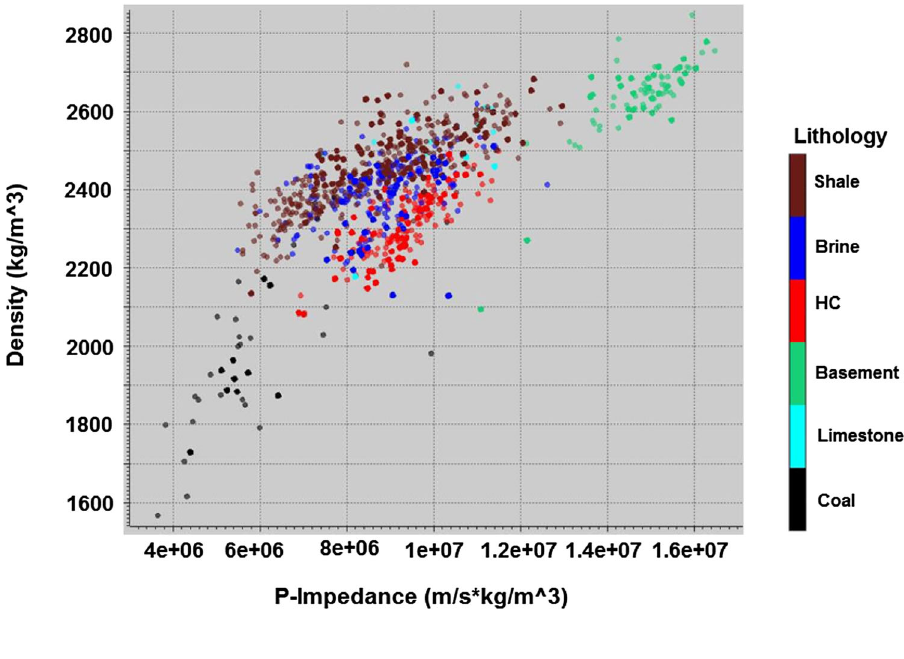
Fig. 23 Compaction trend in density and P-sonic logs cross- plot colored by